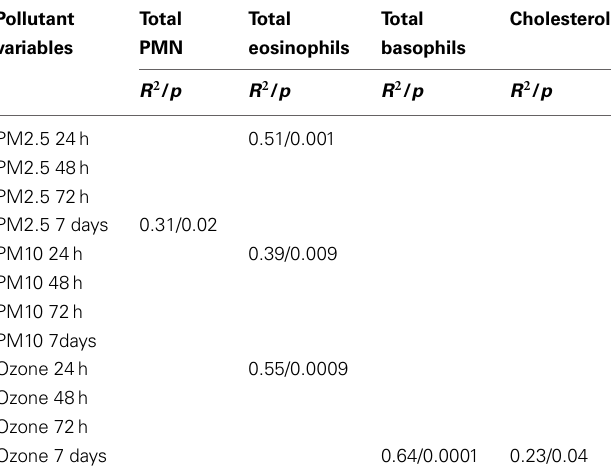
Table 4 | Statistically significant post-cocoa intervention differences in complete Blood Count (CBC) variables associated with PM and ozone cumulative